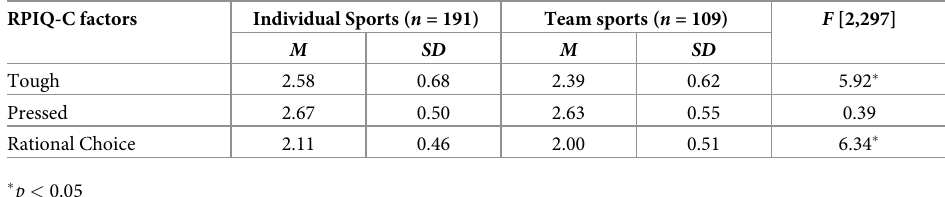
Table 6. Differences in the RPIQ-C factors by types of